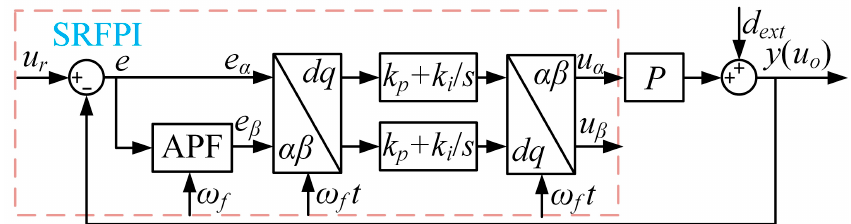
Figure 6. Equivalent block diagram of SRFPI-based voltage controller.